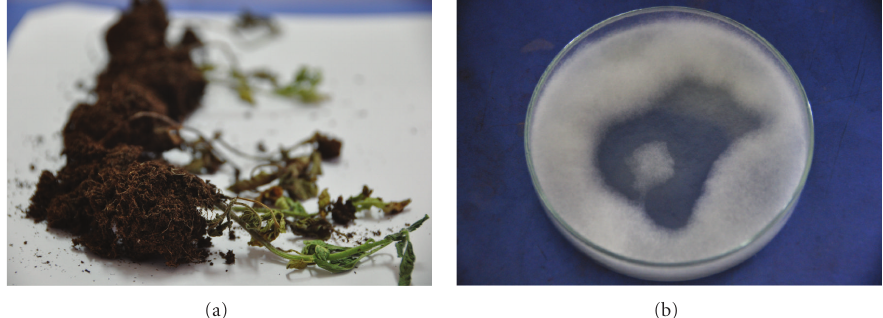
Figure 1: Phytophthora infestans isolated from infected tomato plant seedling (a) and produced white, profusely branching mycelium (b).